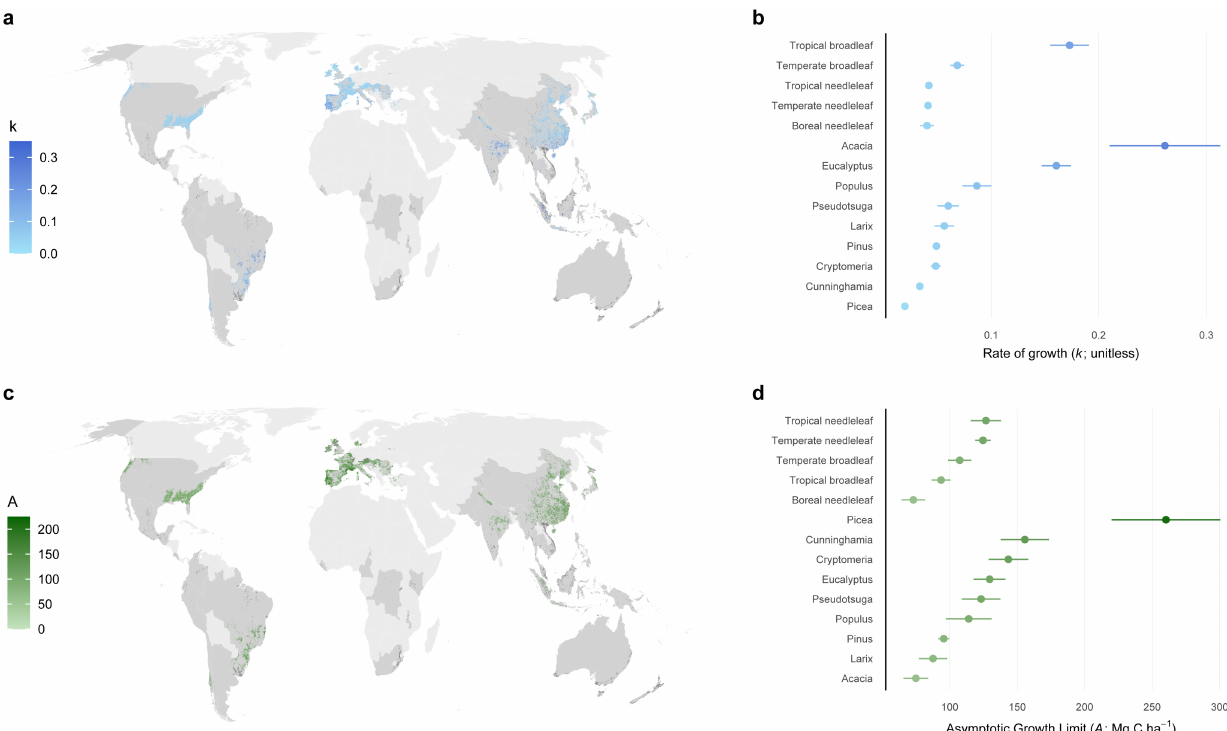
Fig. 2 Variation in aboveground carbon accumulation across global monoculture plantations. Variation in growth rates ( a , b ) and asymptotic growth limits ( c , d ) of global timber and wood fi ber plantations. The locations of timber and wood fi ber plantations are taken from the Spatial Database of Planted Trees 63 . Genus level growth rates and limits are shown preferentially over those for plant functional type. Plantations with unknown species or plant functional type composition are colored dark grey. Countries in light grey did not have information on spatial location of plantations due to a lack of data collection or the absence of plantations. The points in b and d are the estimated model parameter values, and the standard errors of the model parameters are shown as error bars. The number of observations associated with the model parameters and standard errors vary by plant functional type and genus and are given in Figs. 2 and